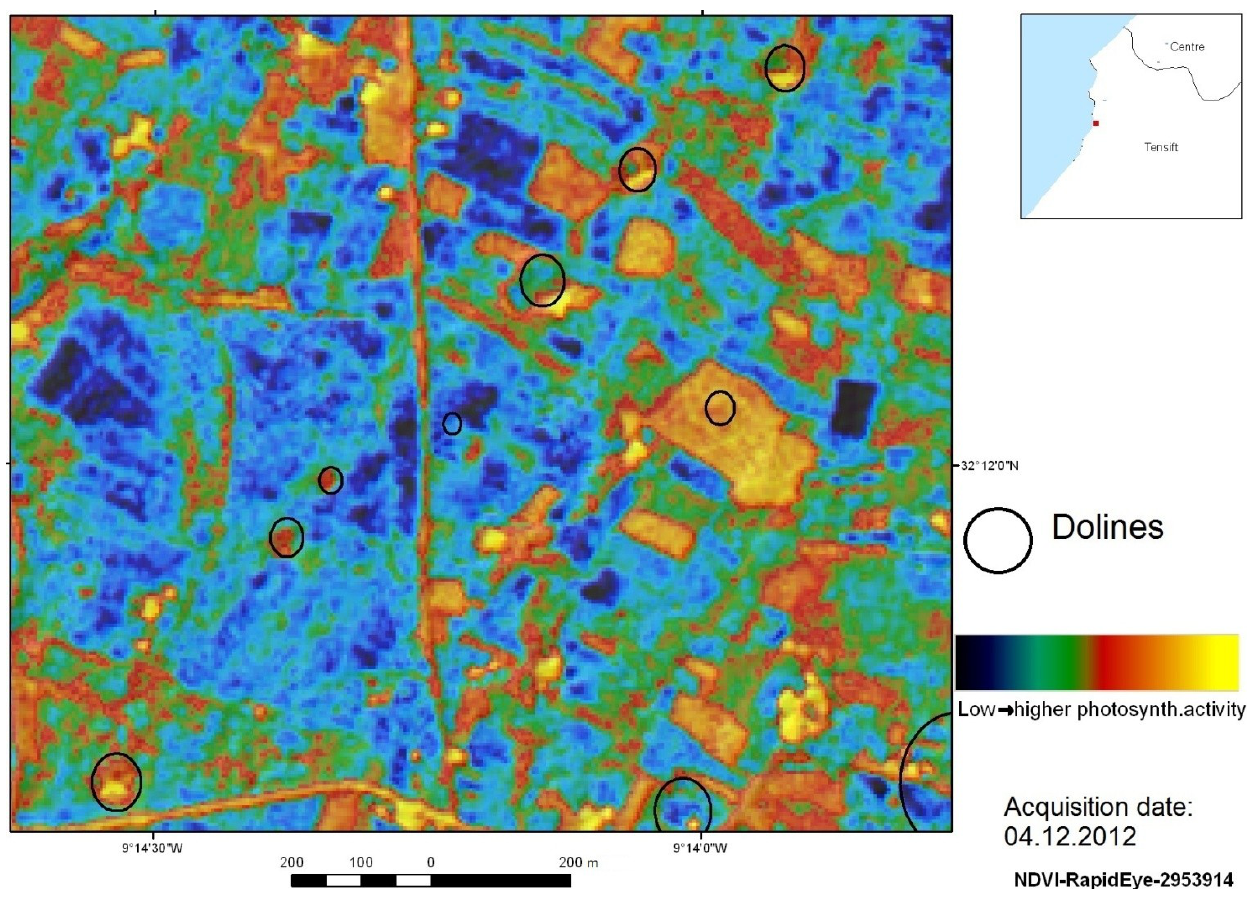
Figure 11. Vegetation index image based on RapidEye data (4 December 2012). Blue color: lower photosynthetic activity; orange to yellow colors: higher photosynthetic